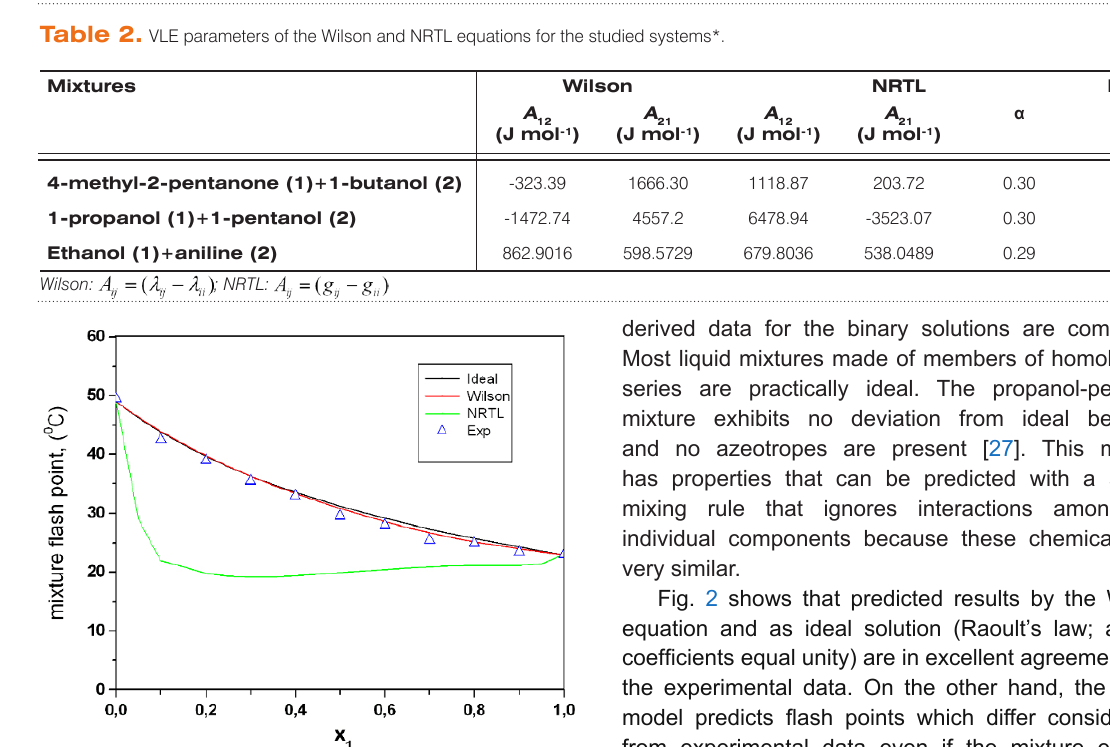
Figure 2. Comparison of the flash point prediction curves with experimentally derived data for 1-propanol (1)